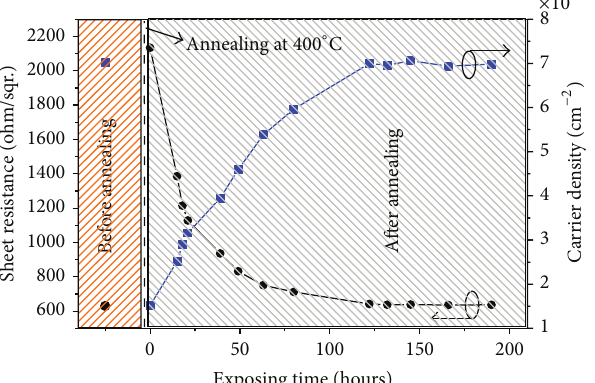
Figure 7: The electrical properties of Gr film before and after annealing at 400 ∘ C and their evolution with the exposing time after thermal annealing